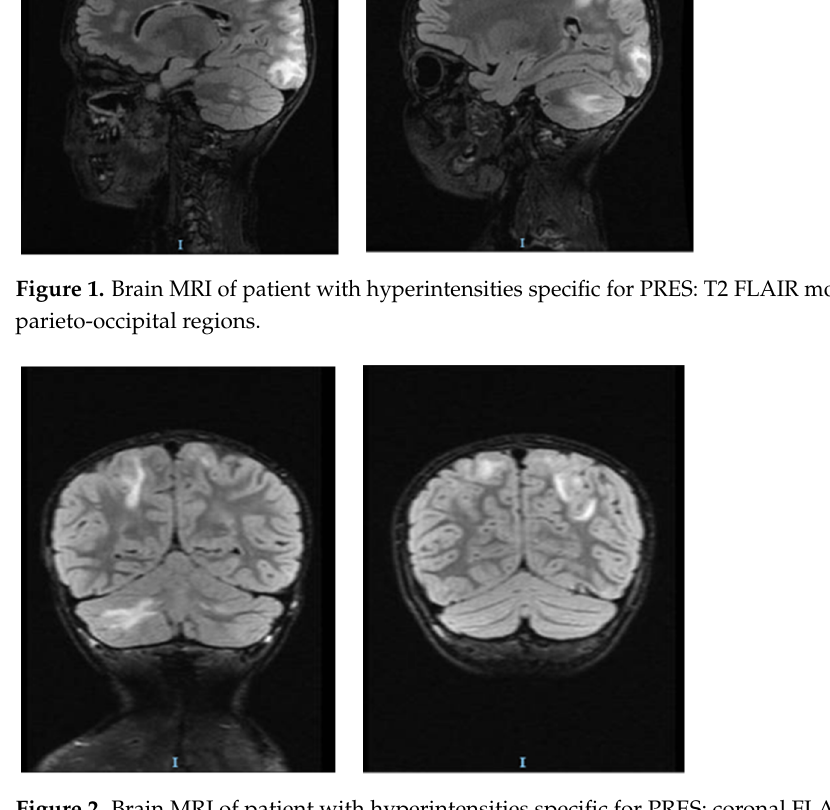
Figure 2. Brain MRI of patient with hyperintensities specific for PRES: coronal FLAIR modifications in the bilateral frontal and left cerebellar regions.